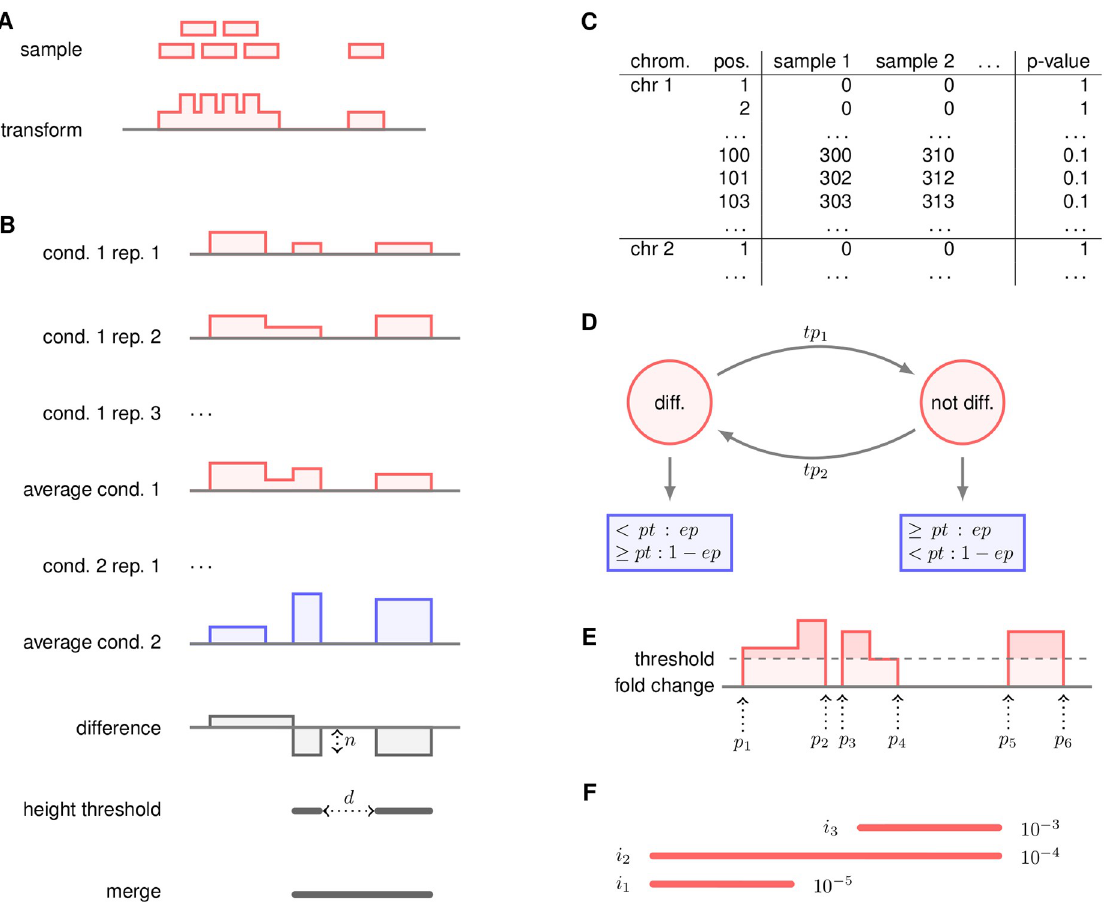
Fig 2. Description of the steps. A : Transformation from mapped reads to run-length encoding. The reads themselves are lost, only the coverage is kept. For the sake of memory compactness, the coverage is stored as a vector of pairs (coverage, length) per chromosome. B : The na ï ve method. In a first step, the samples are averaged for each condition, then the (log2) fold change is computed. All those regions with a fold change not less than n are kept. Regions distant than no more than d base pairs are then merged, and given as output of the method. C : First step of the HMM method. The coverage of each nucleotide is computed for every condition. A p-value is produced for each position. D : Second step of the HMM method. An HMM is run on each chromosome. The states are the red circles, and the emission probabilities are the blue rectangles. diff: the “differentially expressed” state. not diff: the “not differentially expressed” state. tp 1 and tp 2 are the transition probabilities. The emission of each state follows a binomial distribution. For instance, the diff. state emits a p-value less than pt with probability ep . All the parameters ( tp , pt and ep ) are editable by the user. E : IR step. The (log2) fold change is printed in red, 0 is given in i solid grey, and the dashed line is the (user given) threshold. Every region above the threshold is a putative differentially expressed region. A simple method could give three regions (between p 1 and p 2 , between p 3 and p 4 , and between p 5 and p 6 ). The IR method aims at merging close-by regions, with no additional parameter (contrary to the na ï ve method). Briefly, the method considers every interval ( p 1 – p 6 , for instance), computes the area above the threshold (in light red), and divides it by the size (here, p 6 − p 1 ). We will call the mean area above the threshold MAAT. The method then considers all the positions, for instance p 3 , between p 1 and p 6 . If the MAAT between p 1 and p 3 , or the MAAT between p 3 and p 6 , is not above the threshold, the interval is split. In the example, the MAAT between p 3 and p 6 is visibly less than the threshold, so the region is split at p 3 . However, the region between p 1 and p 4 is not split, since the MAATs between p 1 and p 2 , p 1 and p 3 , p 2 and p 3 , p 2 and p 3 are all greater than the threshold. F : The merge step. Each interval i 1 to i 3 , is associated to a p-value, written on the right of the interval. A na ï ve approach would discard i 2 and i 3 because they are dominated by i 1 and i 2 respectively. However, i 3 may be an interesting interval, although the signal is not as strong as the signal of i 1 . We can notice that i 2 both dominates ( i 3 ) and is dominated (by i 1 ). Only this interval is